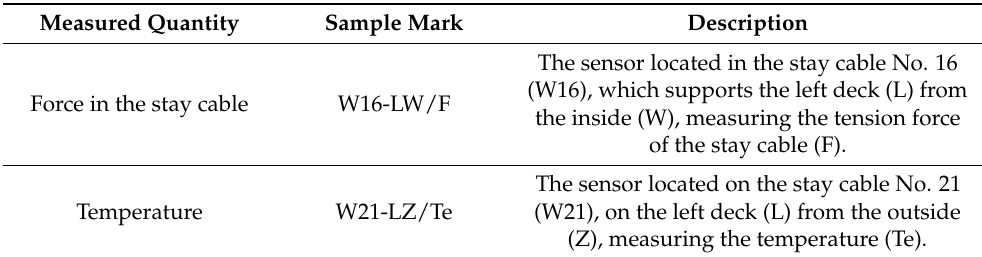
Table 2. Examples of sensor markings.